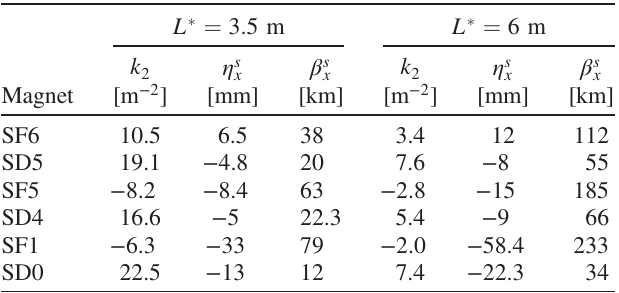
TABLE II. Integrated sextupole strengths k 2 , dispersion η s x , and horizontal β function β s x at the sextupole locations of the FFS for both optimized L (cid:1)